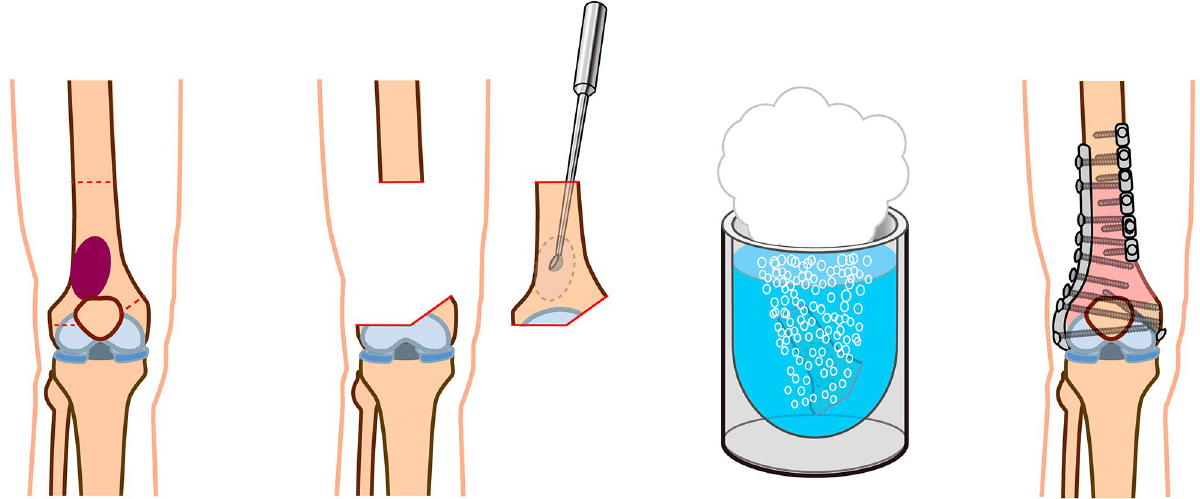
Figure 4. Free freezing procedure. The bone tumor is excised en bloc with an adequate margin. After curettage inside the bone specimen and removal of the surrounding soft tissue, the bone specimen was immersed and frozen for 20 min in liquid nitrogen. After thawing, the devitalized bone was fixed to the residual healthy bone on the original site with double locking